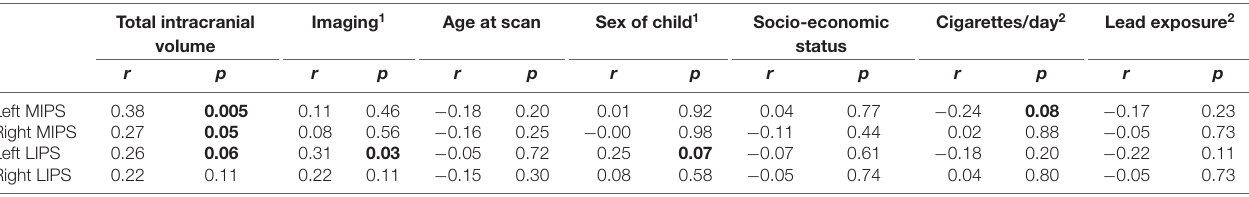
TABLE 3 | Associations of volumes with TIV and potential confounders ( N = 52).